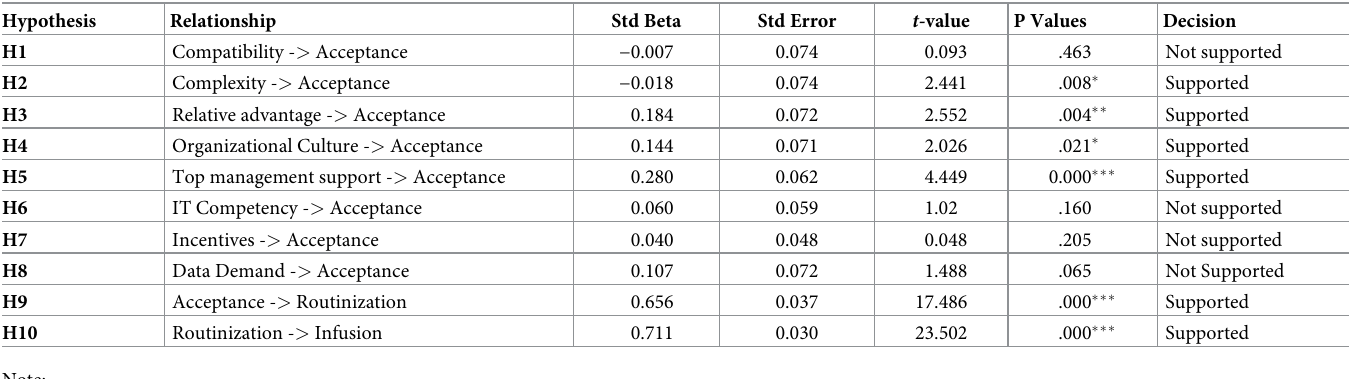
Table 9. Results for the path coefficient analysis.